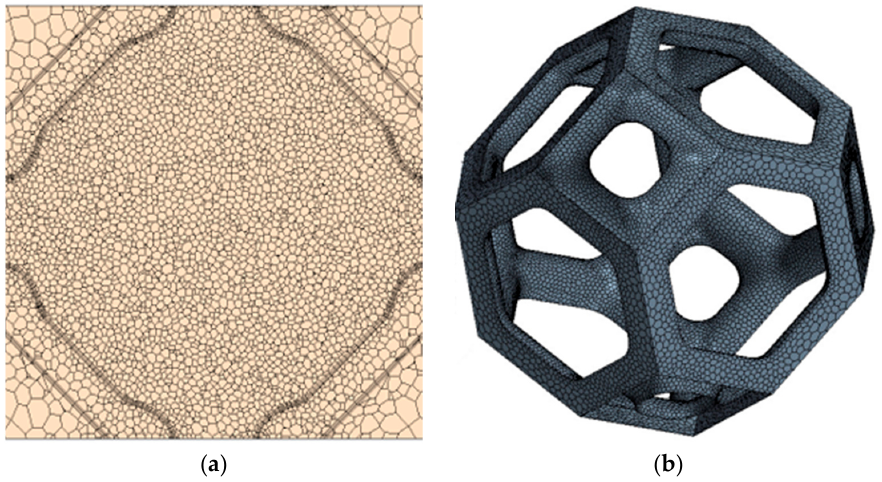
Figure 7. Details of mesh: ( a ) Surface mesh, ( b ) body mesh.